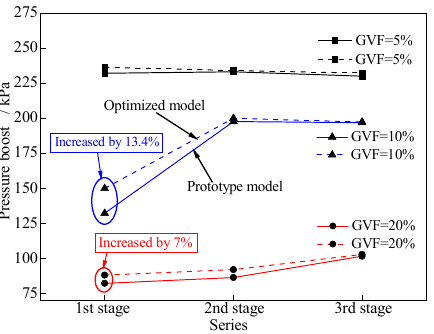
Figure 11. Pressurization of pump at different stages with different GVF.